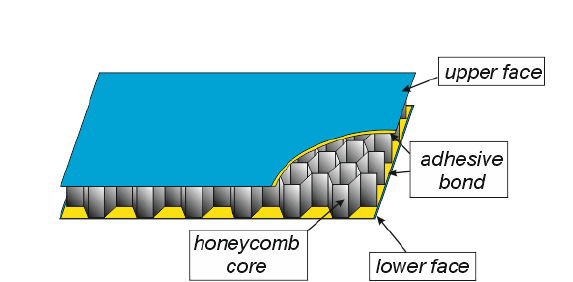
Figure 2. Sandwich plate with a honeycomb